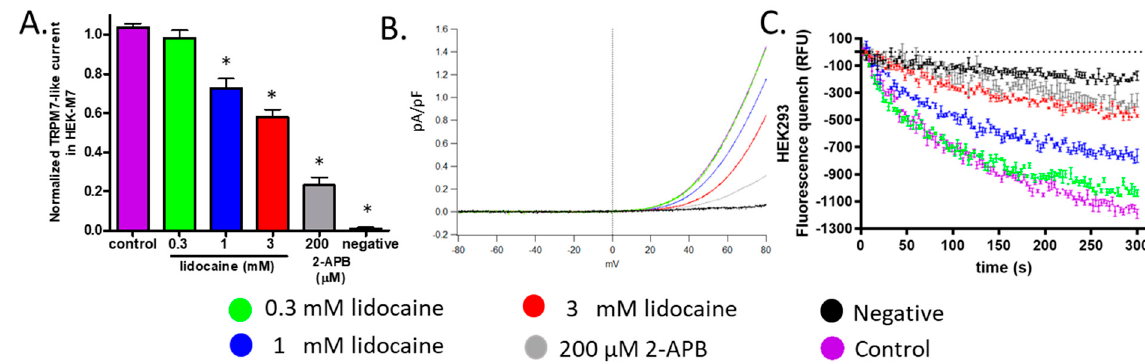
Figure 3. The effect of lidocaine on TRPM7 channels in HEK cells. ( A ). Patch-clamp assay. WT-HEK cells were used as a negative control for the cell model (black). 2-APB (200 µM) was used as a positive control (gray). [lidocaine] ≥ 1 mM suppressed TRPM7-like current in HEK-M7, n = 6, “*” indicates the significant differences ( p < 0.05) compared with the control (purple). ( B ). Representative TRPM7-like current from patch-clamp. ( C ). Fluorescence quench assay: [lidocaine] ≥ 0.3 mM concentration-dependently decreased the influx of Mn 2+ in HEK-M7 cells ( n = 3). Current and quench data of control, negative control, and 200 µM 2-APB were published previously [22].